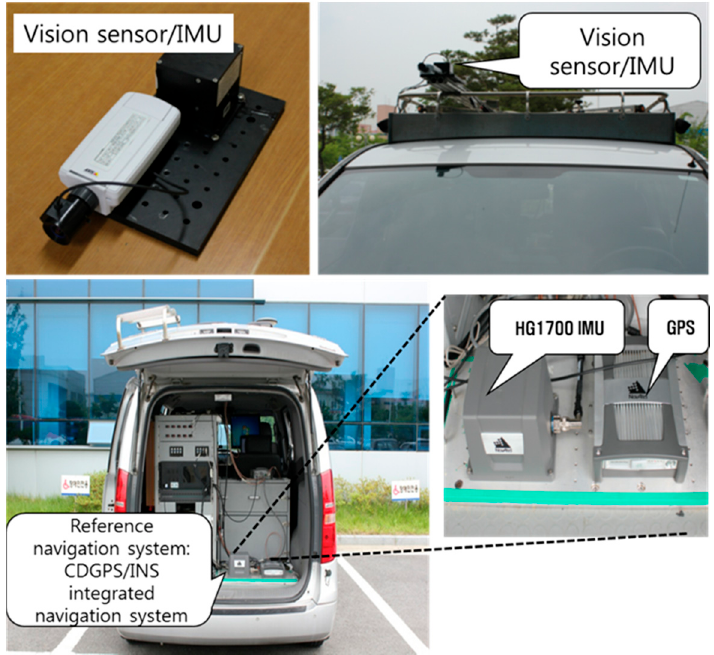
Figure 8. Experimental setup and reference navigation system.